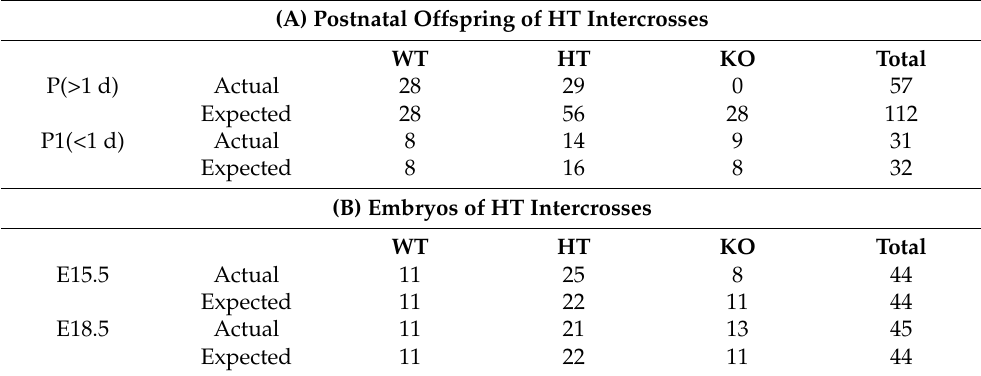
sites of the primers for genotype identification. ( C ) Quantitative RT-PCR analysis of Kub3 mRNA levels in E18.5 embryos. GAPDH was used as an internal control for normalization ( n = 3). ( D ) WB analysis of Kub3 protein level in E18.5 embryos. Total protein lysates were isolated from embryos of WT, HT and KO at E18.5. GAPDH was used as a loading control. ( E ) In situ hybridization (ISH) analysis of Kub3 in WT and KO lungs at E18.5. Kub3 -positive signals are shown as red fluorescence in cells. Nuclei were stained blue with 4 (cid:48) ,6-diamidino-2-phenylindole (DAPI). Scale bar: 20 µ m. Table 1. Genotypes and viability of Kub3 KO mice (HT × HT). (A) Postnatal Offspring of HT